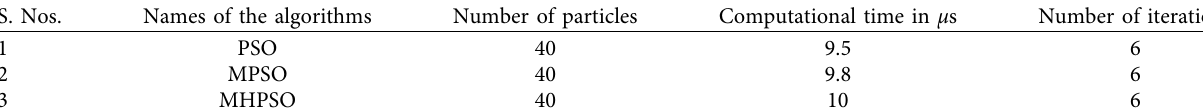
Figure 7: Search point adjustment by using PSO. Table 2: Computation parameters comparison of PSO, MPSO, and MHPSO.